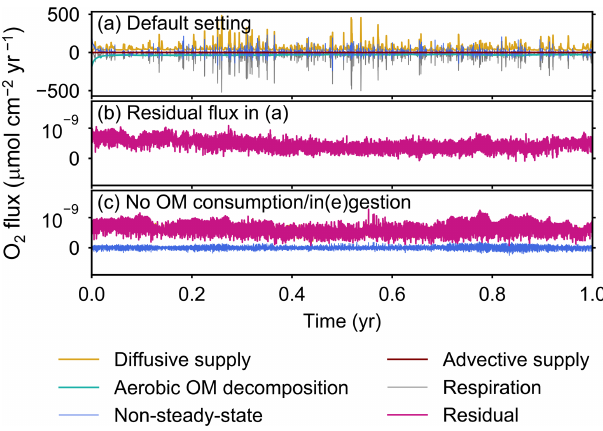
Figure A1. All oxygen fluxes calculated in eLABS. Shown are oxy- gen fluxes caused by a change in the total amount of oxygen in the sediment (“non-steady-state”), aerobic degradation of organic matter (“aerobic OM decomposition”), infaunal respiration (“respi- ration”), water advection (“advective supply”), and molecular plus eddy diffusion (“diffusive supply”), and also the residual oxygen flux as the sum of the above fluxes (“residual”) in the (a) default simulation and (c) simulation without oxygen consumption and in- gestion/egestion. Figure A1b shows only residual oxygen flux in panel (a)